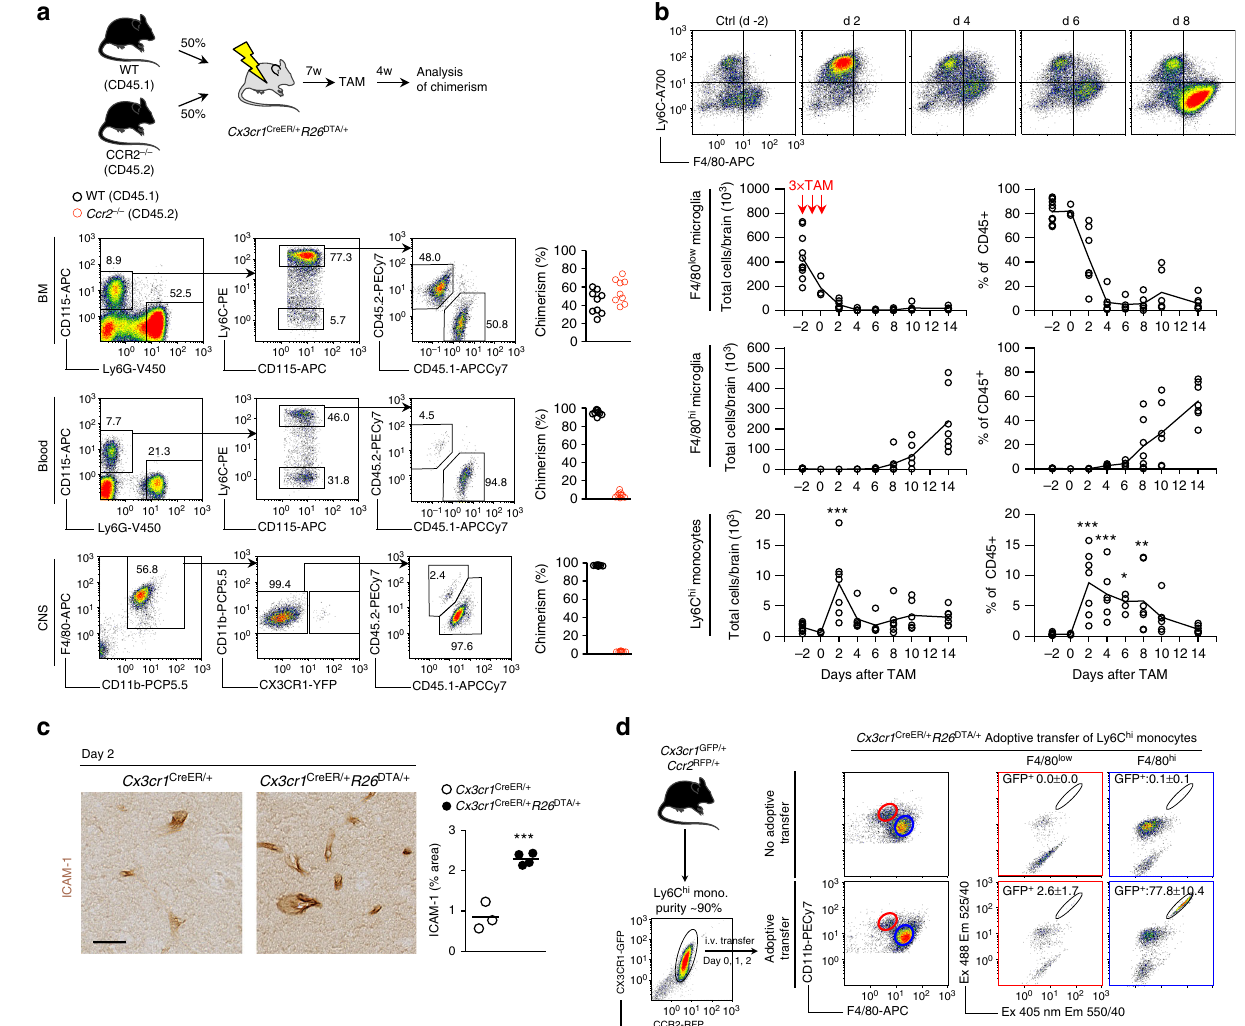
Fig. 3 F4/80 hi macrophages are derived from CCR2 + Ly6C hi monocytes. a Analysis of BM, blood and CNS chimerism in WT: Ccr2 – / – → Cx3cr1 CreER/ + R26 DTA/ + competitive chimeras. In all organs gated on live singlet cells. n = 9 mice. The experiment was performed twice. b Kinetic analysis of Ly6C hi monocytes in relation to F4/80 low microglia and F4/80 hi macrophages in the CNS during depletion in Cx3cr1 CreER/ + R26 DTA/ + mice. Representative fl ow cytometry plots are gated on CD11b + CD45 hi Ly6G – cells. Ly6C hi , F4/80 low , and F4/80 hi gated as indicated in Supplementary Fig. 1. Data is from two pooled experiments. n = 12, 3, 7, 6, 5, 7, 6, 7 mice/time point. Connecting lines represent mean values. ** p < 0.01, *** p < 0.001 by one-way ANOVA with Dunnett ’ s Multiple Comparison test. c Activation of the cerebral vasculature as assessed by ICAM-1 staining on day 2 after TAM administration. Quanti fi cation was performed in the thalamus on n = 3 and 4 mice/group and 3 sections/mouse. Scale bar 25 µ m. Lines represent mean values. *** p < 0.001 by Student ’ s unpaired two-tailed t -test. d Analysis of reconstitution of the F4/80 low and F4/80 hi compartments after adoptive transfer of 1.7 – 3.0 × 10 6 Ly6C hi monocytes/day from Cx3cr1 GFP/ + Ccr2 RFP/ + mice into microglia-depleted Cx3cr1 CreER/ + R26 DTA/ + mice on days 0, 1, and 2 after TAM administration. Gated on CD11b + Ly6C – . Analysis of CNS was performed day 14 after TAM administration. Successful separation of GFP and YFP signals is demonstrated in Supplementary Fig. 3. Values are mean ± s.d of 4 mice/group. The experiment was performed